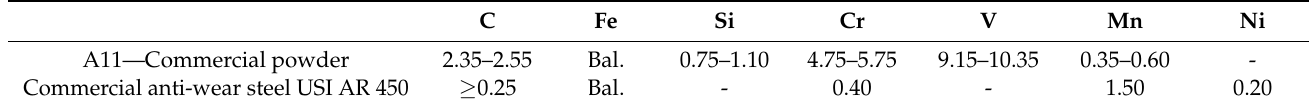
Table 1. Chemical composition of the specimens (wt.%).